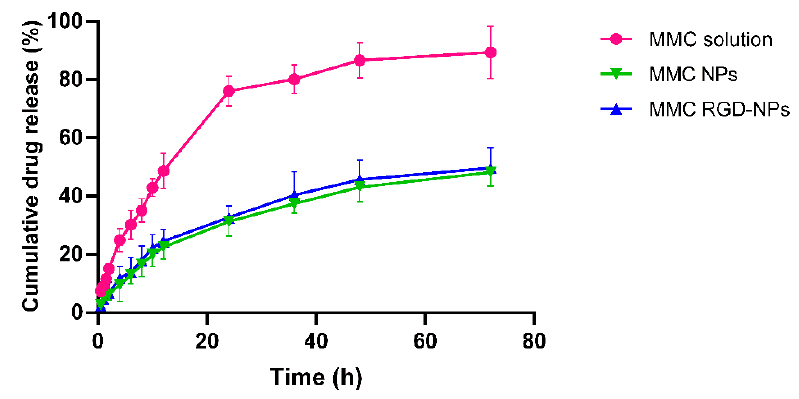
Figure 6. Study of release behavior of MMC RGD-NPs, in pH 7.4, in vitro.